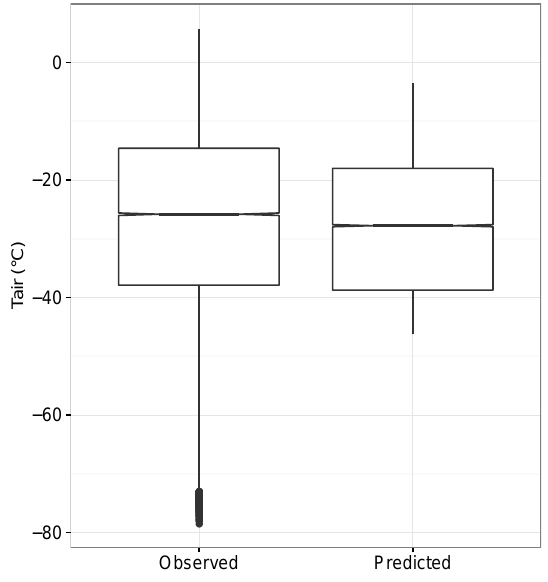
Figure 4. Correlation between measured and predicted T air based on LOSOCV of ( a ) the linear model, ( b ) RF, ( c ) Cubist and ( d ) GBM. The intensity of the color represent the data point density.